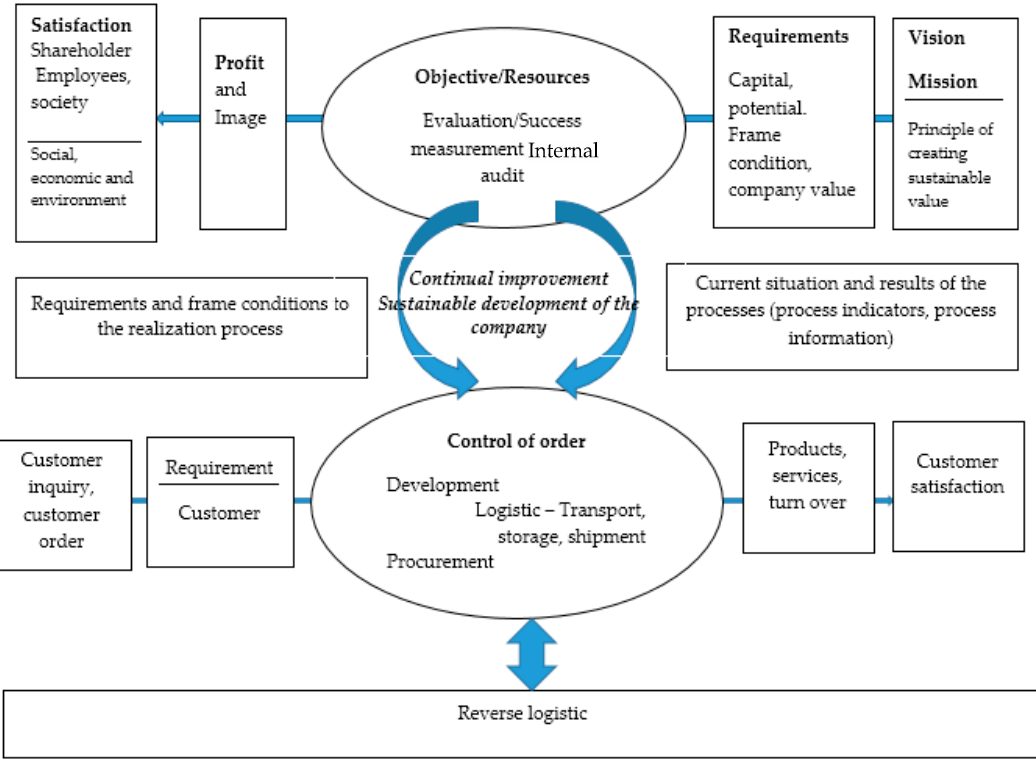
Figure 5. Process model for manufacturing industry.